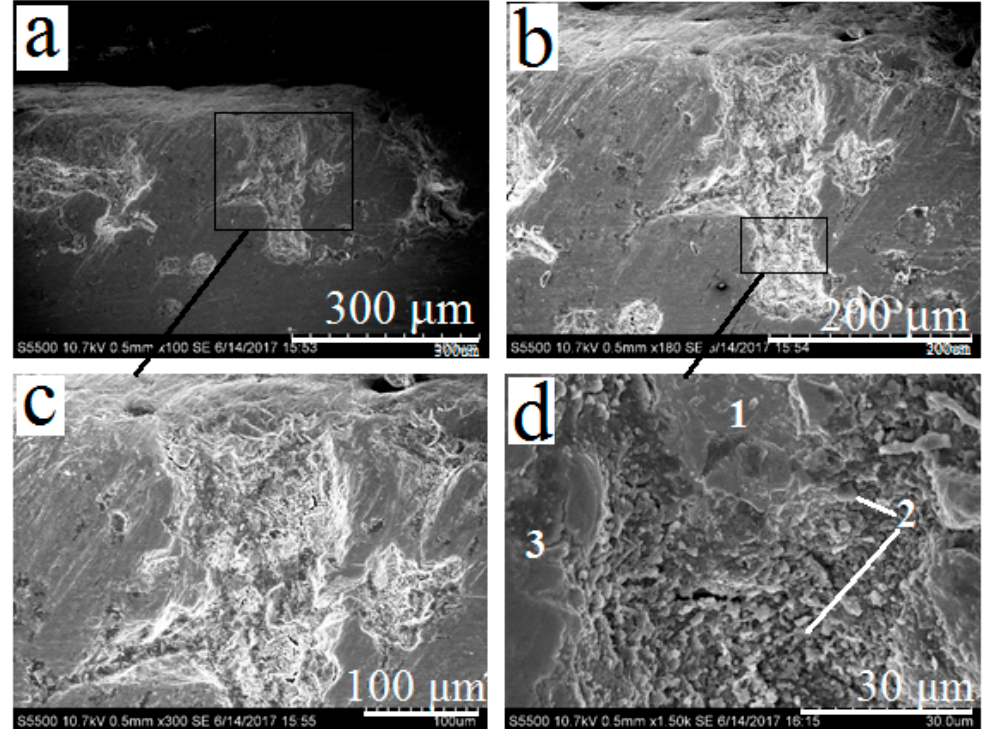
Figure 7. Cross-section of porous oxidized titanium samples (series 4) after coating. Phases are marked as follows: 1—solidified PbSiO 3 ; 2—TiO 2 layer; 3—titanium substrate. Magnifications: 100 × ( a ), 180 × ( b ), 300 × ( c ), 1500 × ( d ).